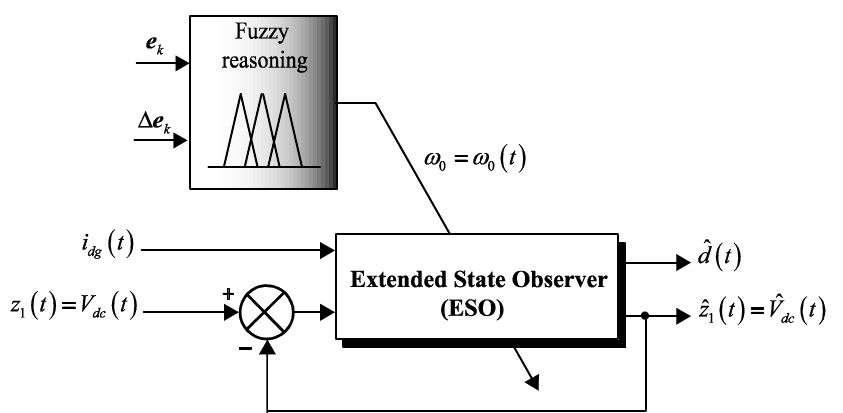
Figure 2. Adaptive fuzzy ESO ‐ based SOSM controller for the DC ‐ link voltage.